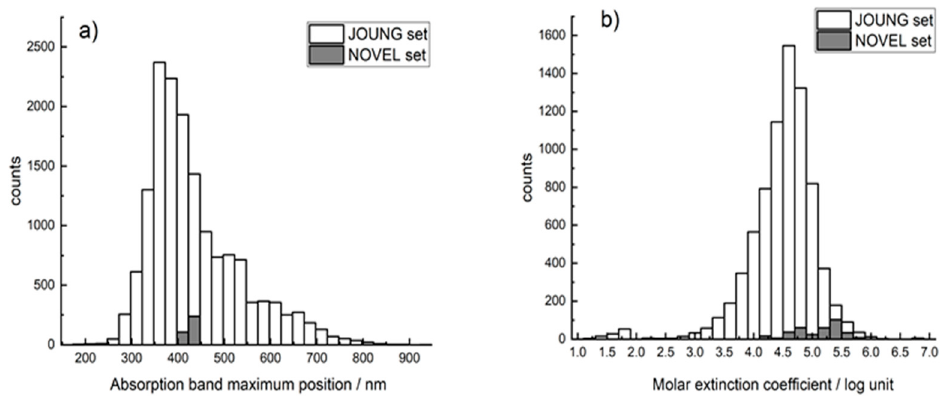
Figure 1. Histogram of the distribution of JOUNG and a NOVEL set of 335 porphyrins synthesized in our laboratory by absorption wavelengths ( a ) and the value of the extinction coefficient ( b ).